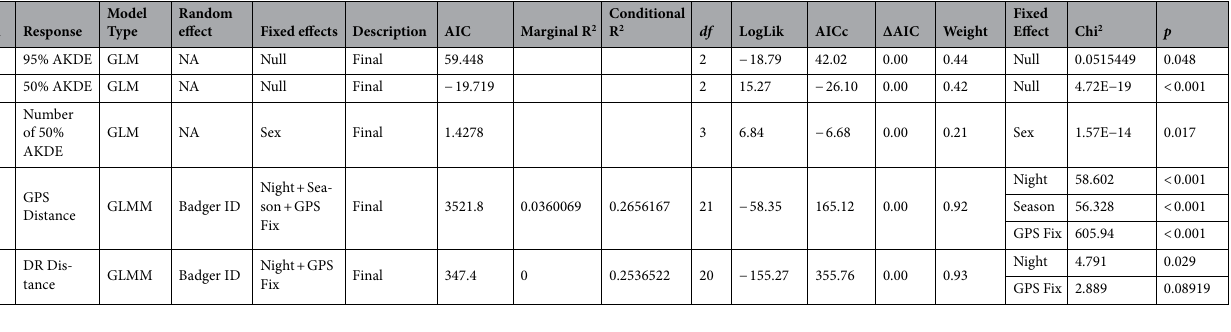
Table 1. General Linear Model (GLM) and General Linear Mixed Model (GLMM) selection. Summaries of selected models for each with the AICc-best fit model are shown